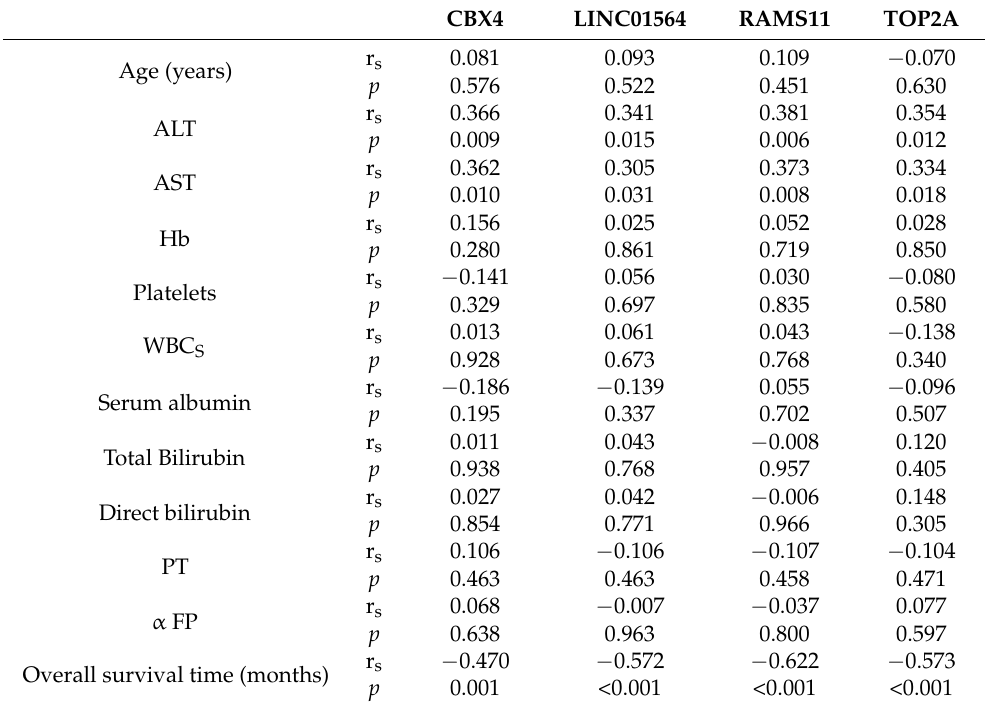
Table 5. Correlation between different gene expression with laboratory data and overall survival in HCC group (n = 50).